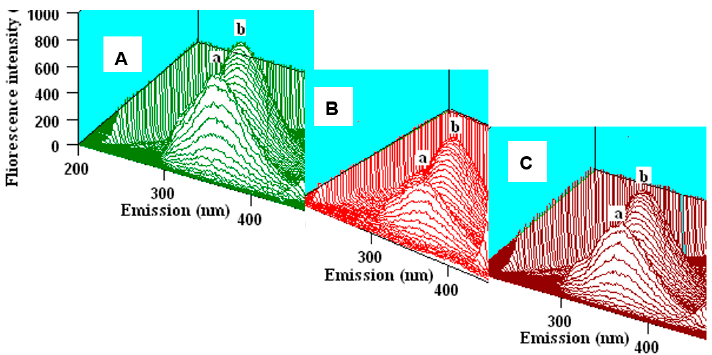
Figure 2. Three-dimensional fluorescence (3D-FL) spectra of interaction of human serum albumin (HSA) with polyphenols water extracts of kiwifruit and persimmon ( A – C ): HSA in water; HSA + ’Hayward’, HSA +’Fuyu’. Excitation wavelength scan: 200–500 nm. Emission wavelength scans between 200–400 nm. Fluorescence intensity is estimated in arbitral units. The values of peaks a and